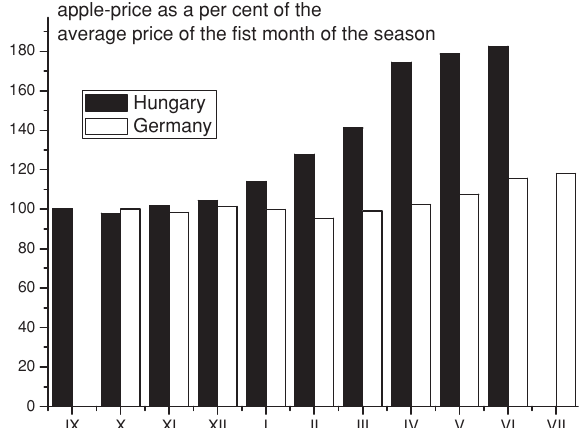
Figure 5. Change of apple-prices during the seasons in Germany and Hungary for Golden Delicious